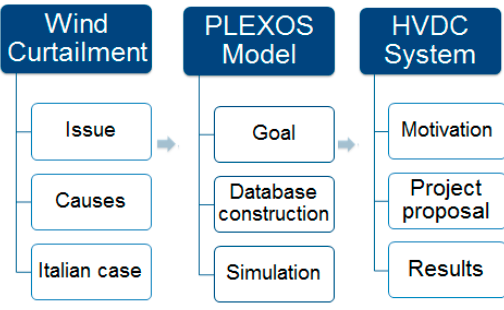
Figure 2. Outline of the problem.